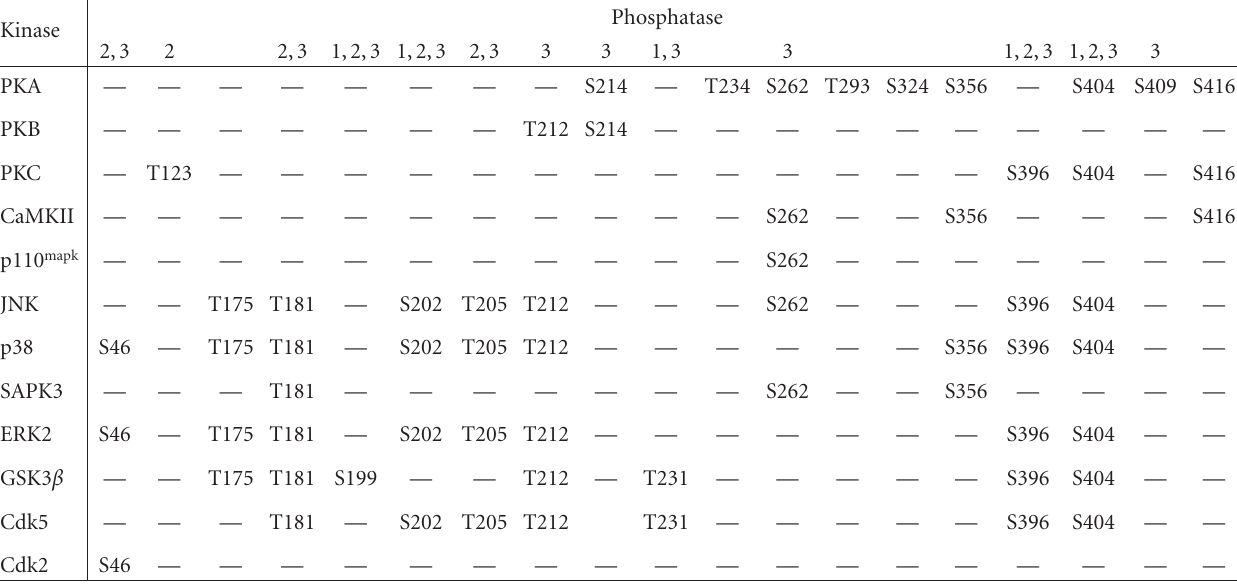
Table 1: Summary of the di ff erent protein kinases implicated in Tau phosphorylation, the exact residues that are modified by them and the phosphatases that participate in the dephosphorylation process of each residue. Phosphatases are (1) PP1, (2) PP2A, and (3) PP2B. See [70–73].